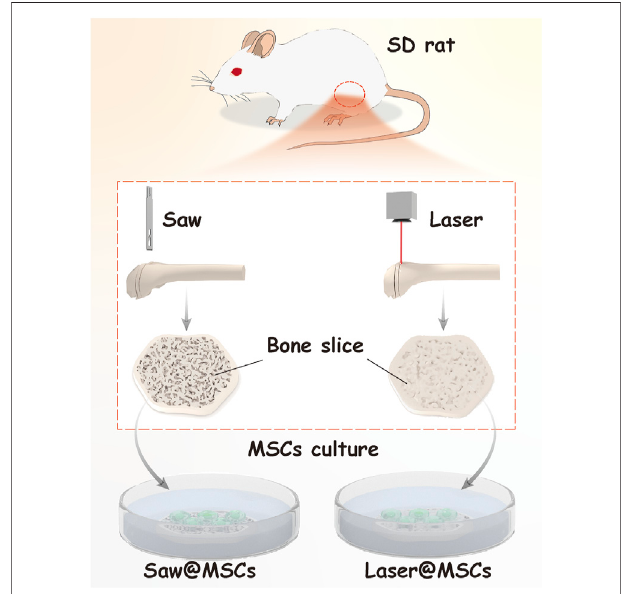
FIGURE 2 | Preparation of bone slices and cell